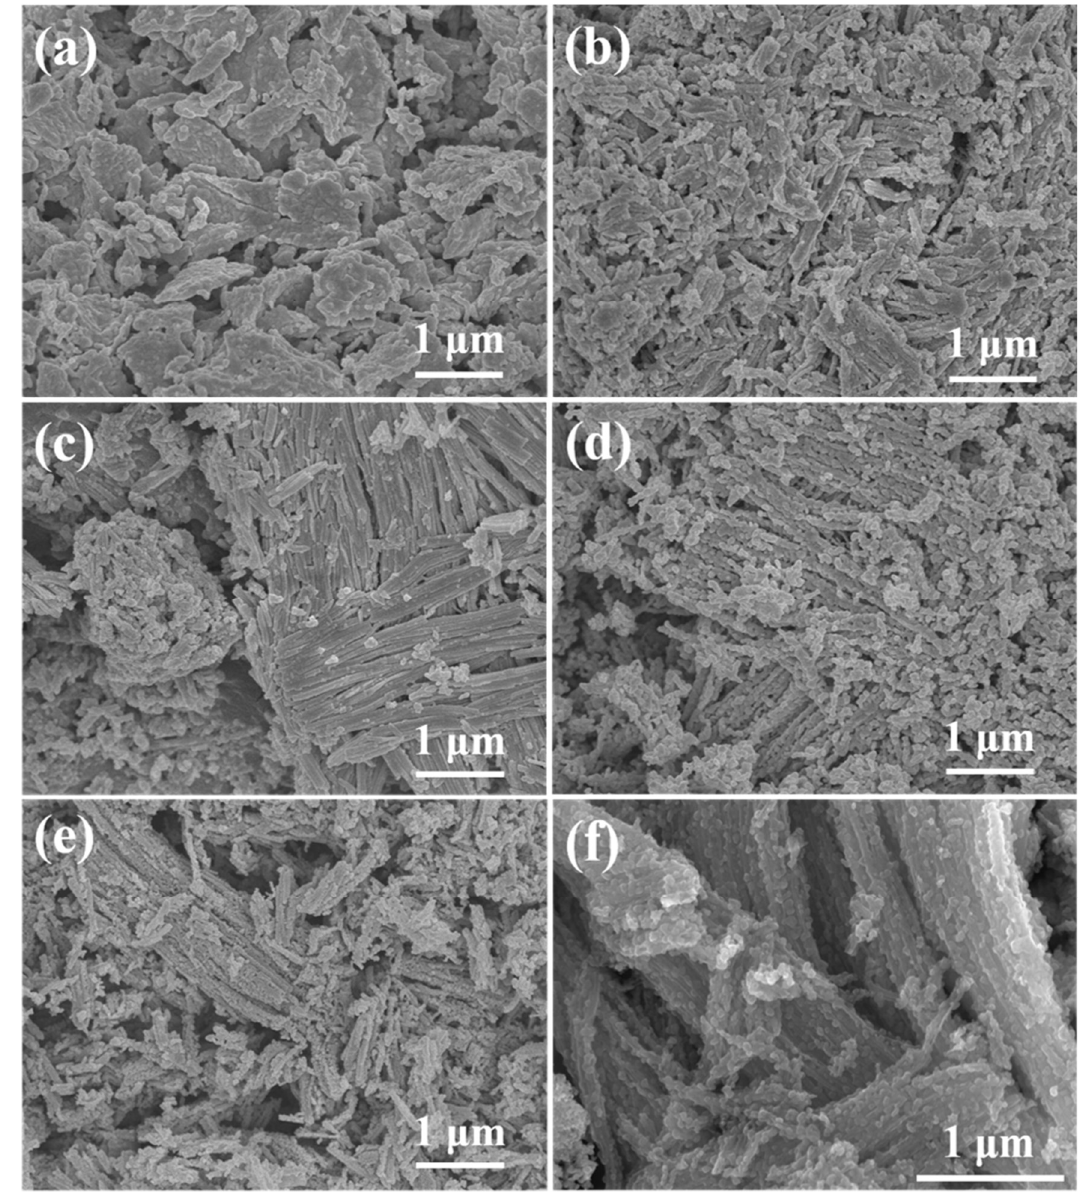
Figure 3. SEM images of various metal doped molybdenum carbide catalysts ( a ) 2% Fe-Mo 2 C; ( b ) 2% Co-Mo 2 C; ( c ) 2% Ni-Mo 2 C; ( d ) 2% Cu-Mo 2 C; ( e ) 2% Ag-Mo 2 C; ( f ) 2% Pt-Mo 2 C.